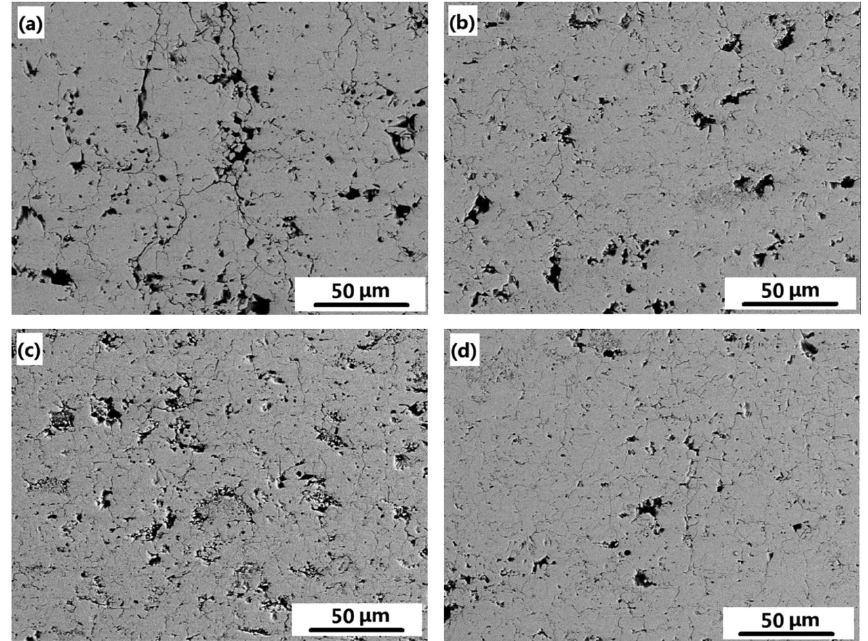
Fig. 49 Cross-sectional SEM images of plasma-sprayed TBCs with different amounts of defects for as-sprayed coatings: (a) A1, (b) S1, (c) S2, and (d) S3. Reproduced with permission from Ref. [254], © Elsevier B.V.